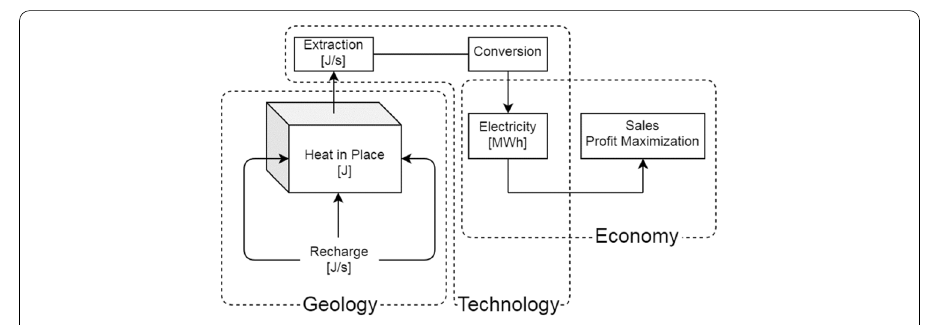
Fig. 2 Schematic model illustration